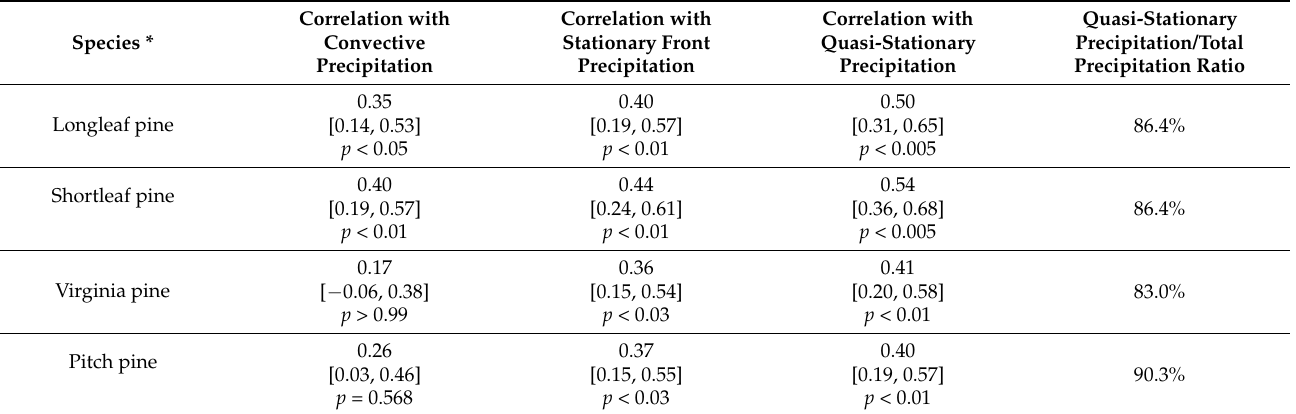
Table 1. Correlations between convective, stationary front, and quasi-stationary precipitation with each species and the ratio of quasi-stationary precipitation to total precipitation during 1940–2020. Quasi-stationary precipitation is the combination of convective and stationary front precipitation.